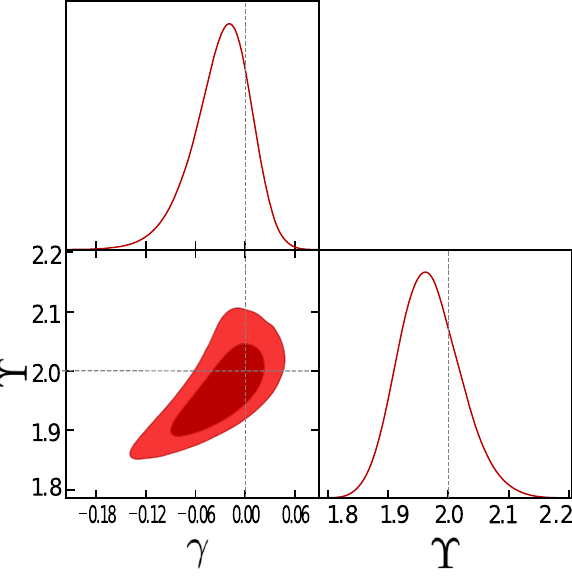
Fig. 2 Posteriori probability distribution of free parameters γ and f e for SIS model considering σ int ≈ 12 . 22%. The vertical dashed lines correspond to no variation of α and σ SIS = σ 0